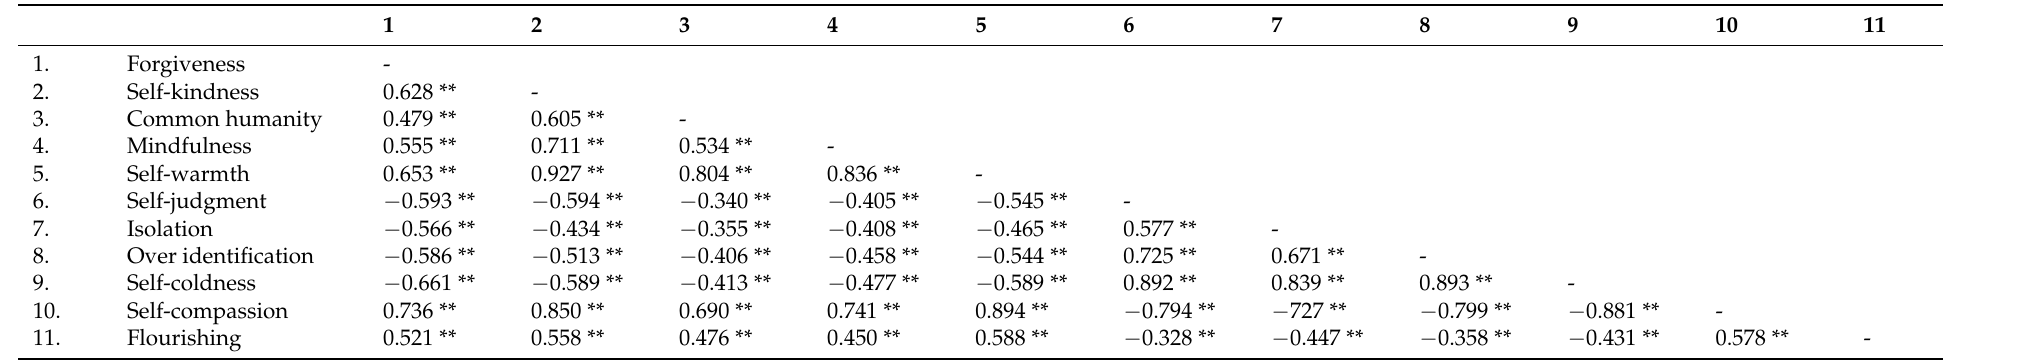
Table 1. The bivariate correlations (Spearman’s rho) between forgiveness, flourishing, and